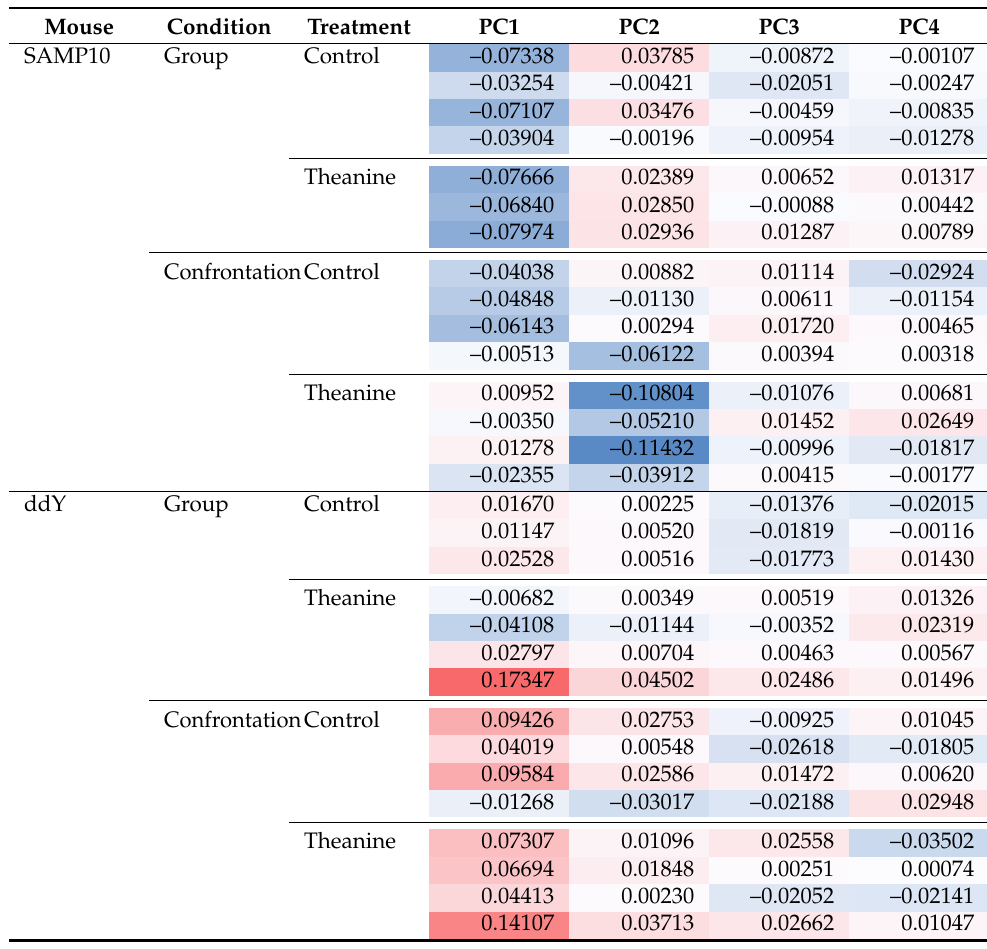
Table 1. Data of principal component analysis of metabolites in senescence-accelerated mouse prone 10 (SAMP10) and ddY